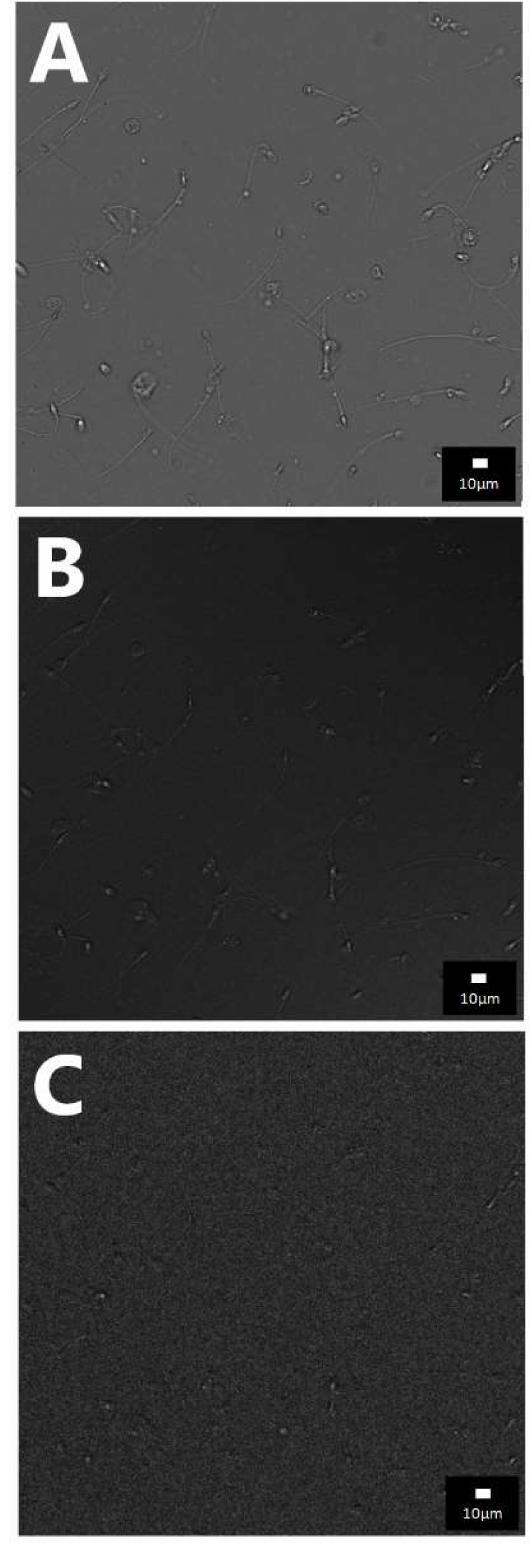
Figure A2. Application of different filters with one objective, Leica DIC 20 × NA 1.0 OIL (total magnification 100 × ): ( A ) 405 nm, ( B ) 550 nm, ( C ) 670 nm. The 405 and 550 nm show filters sufficient amount of detail. The 670 nm filter requires a more sensitive camera or more